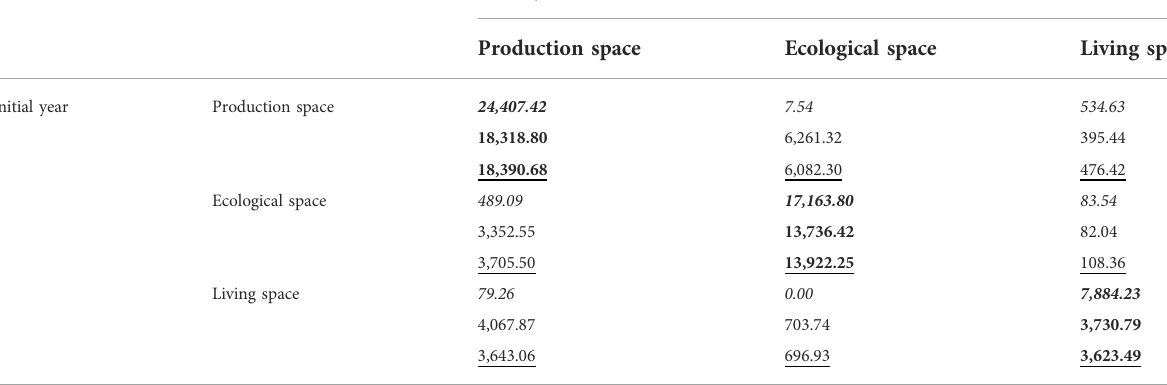
TABLE 2 Transfer matrix of the primary land-use space from 2009 to 2020 (hm 2